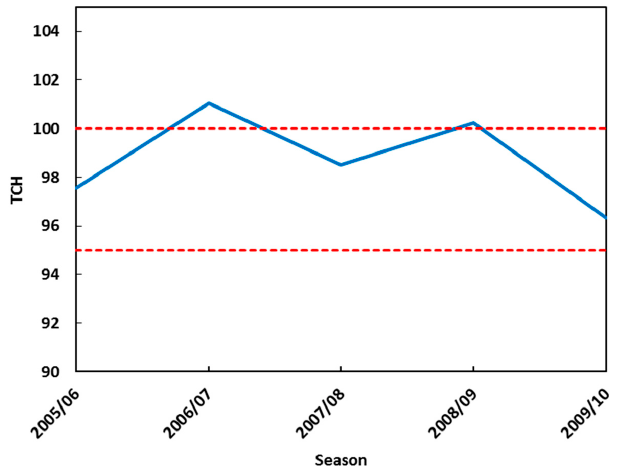
Figure 7. Temporal variation of yield (TCH/season) of the sugarcane industry.